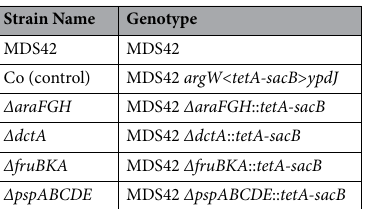
Table 1. Bacterial strains used in this study. The < tetA-sacB > designation indicates the insertion of the cassette in an intergenic region of two genes.